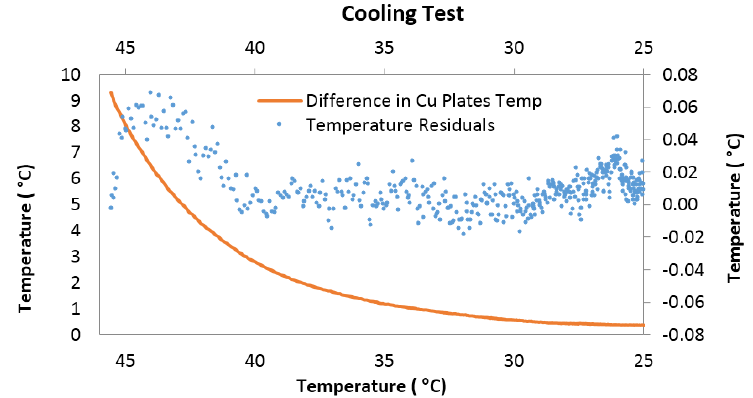
Figure 9. Profile of temperature difference of Cu plates and temperature residuals of fitted curve (cooling Test, with respect to temperature).